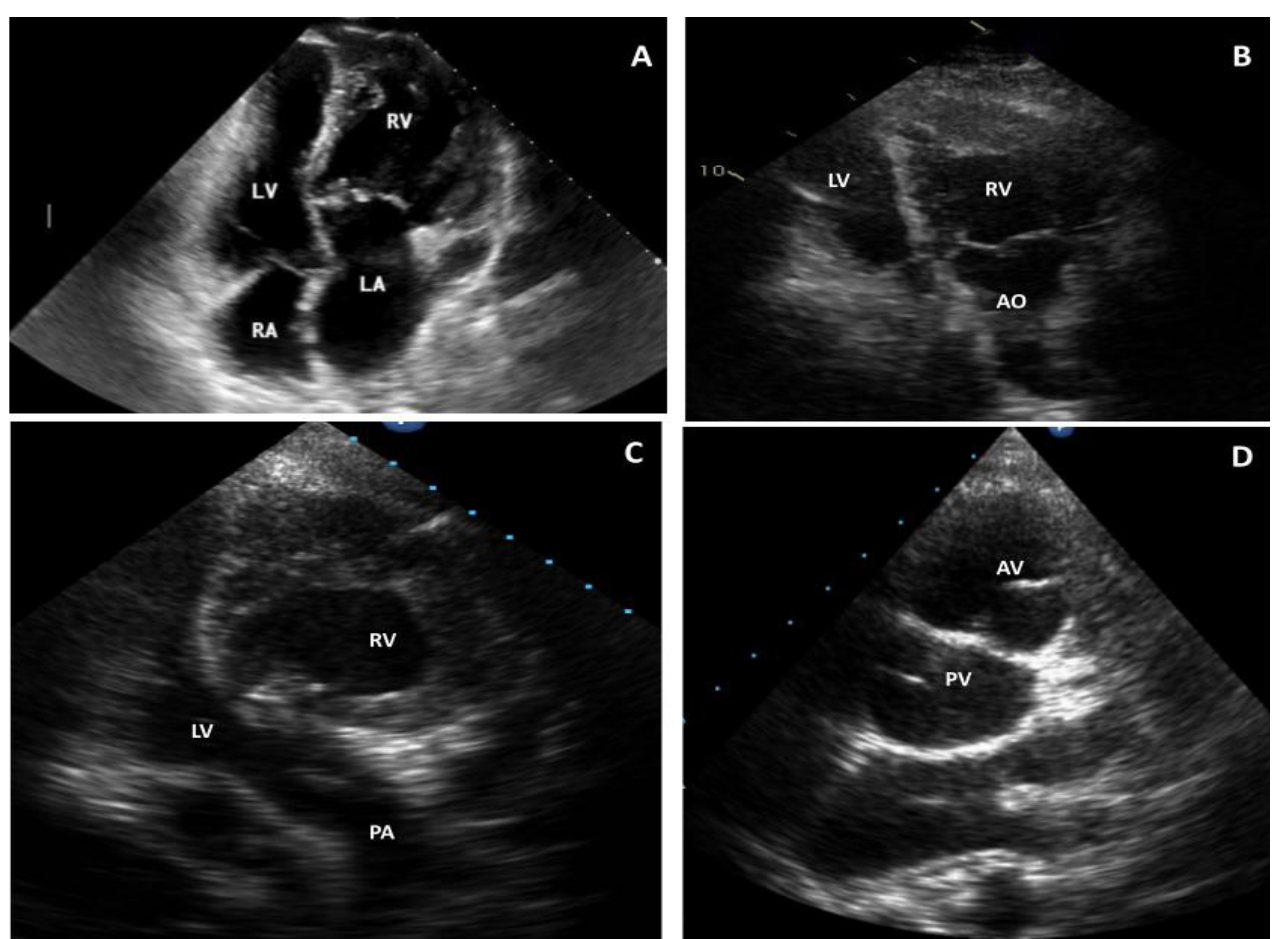
Fig. 2 - Bidimensional echocardiograms in patients with congenitally corrected transposition of the great arteries. A) 16-year-old patient, four-chamber view. Discordant atrioventricular connections plus moderate tricuspid regurgitation (TR) and mild pulmonary stenosis (PS); B) 35-year-old patient, apical view. Left-sided right ventricle (RV) connected to aorta (AO) plus mild TR/PS after Rastelli operation; C and D) 24-year-old patient with mild TR. Apical view (right-sided left ventricle [LV] connected to pulmonary artery [PA]) (C) and short axis